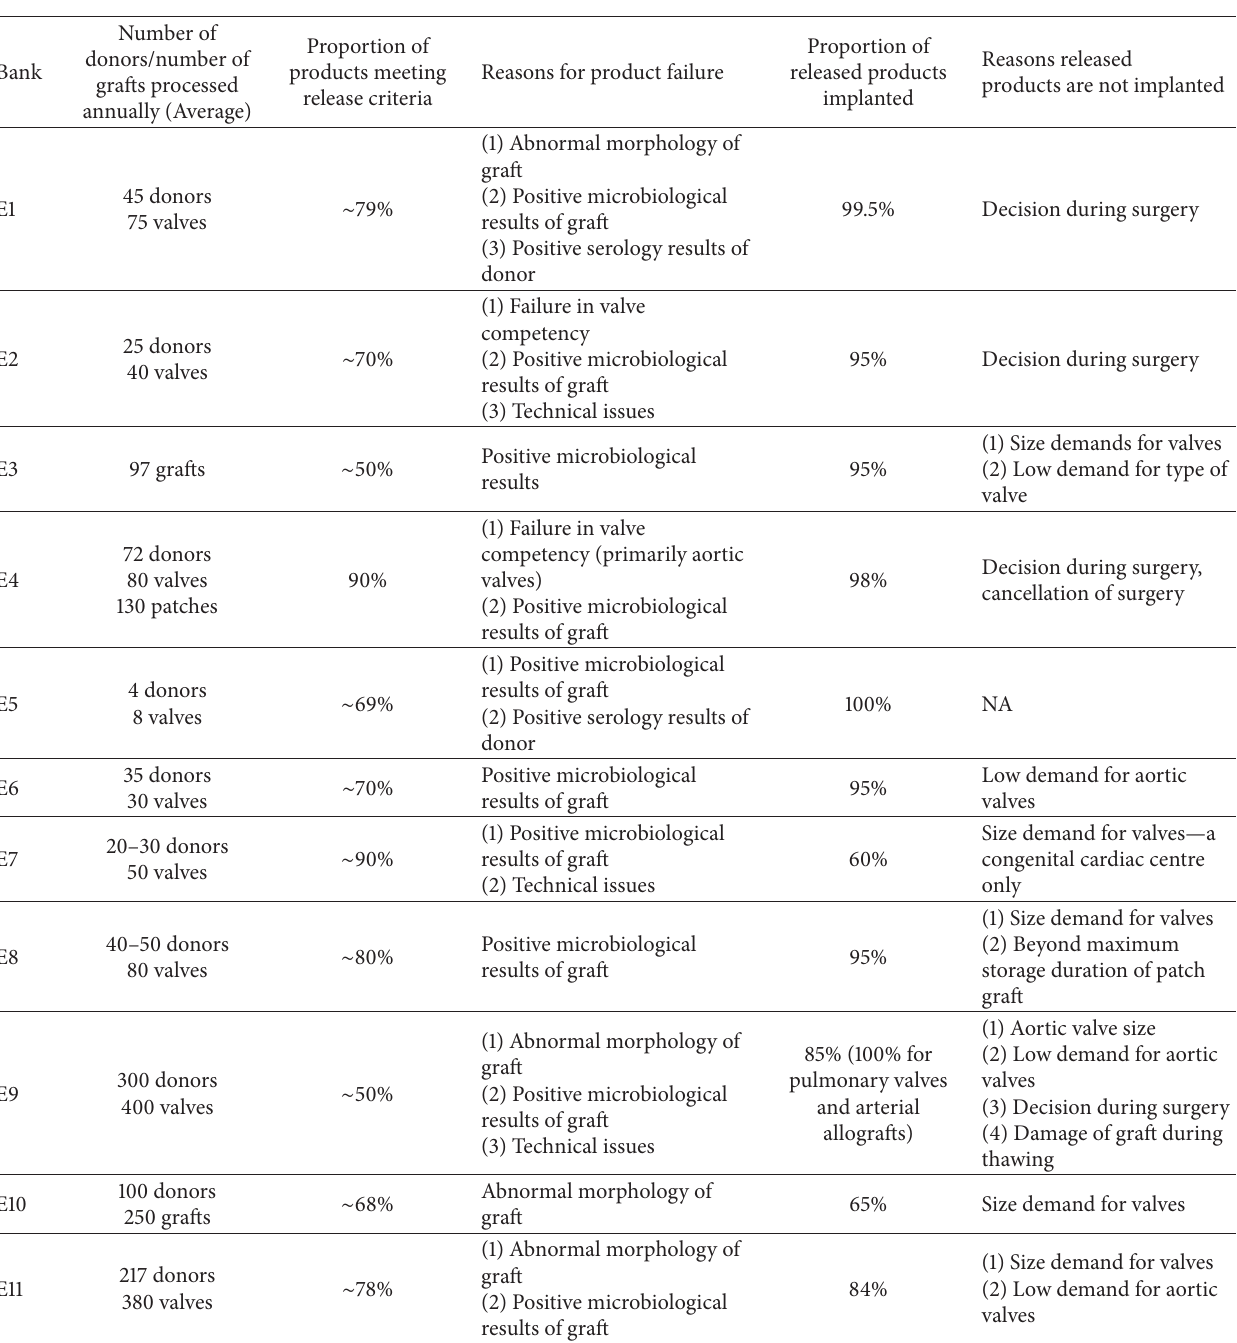
Table 7: Summary of heart valve outcomes for HVBs in